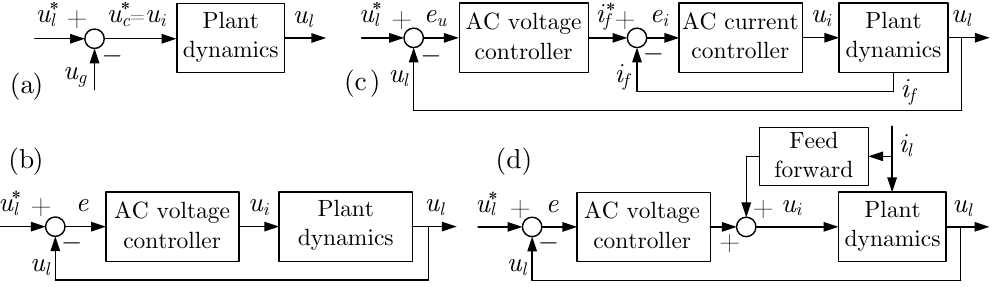
Figure 1. Most relevant dynamic voltage restorer (DVR) control strategies: ( a ) open-loop control, ( b ) single-loop control, ( c ) multi-loop control, and ( d ) single-loop control with current